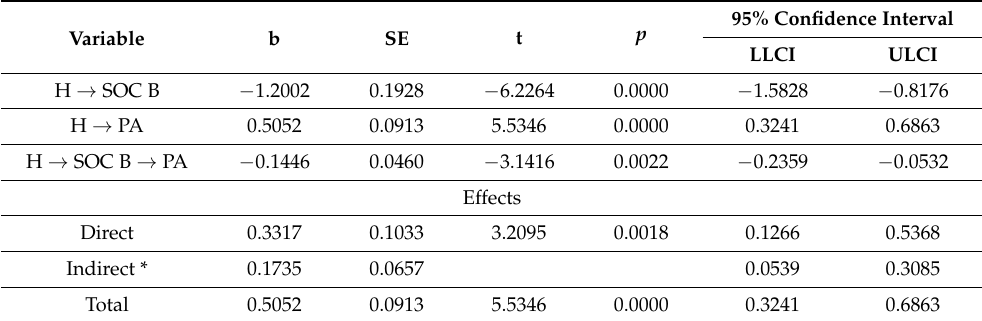
Table 8. Mediation analysis of comprehensibility (SOC B) on hostility (H)–physical aggression (PA) relationship.